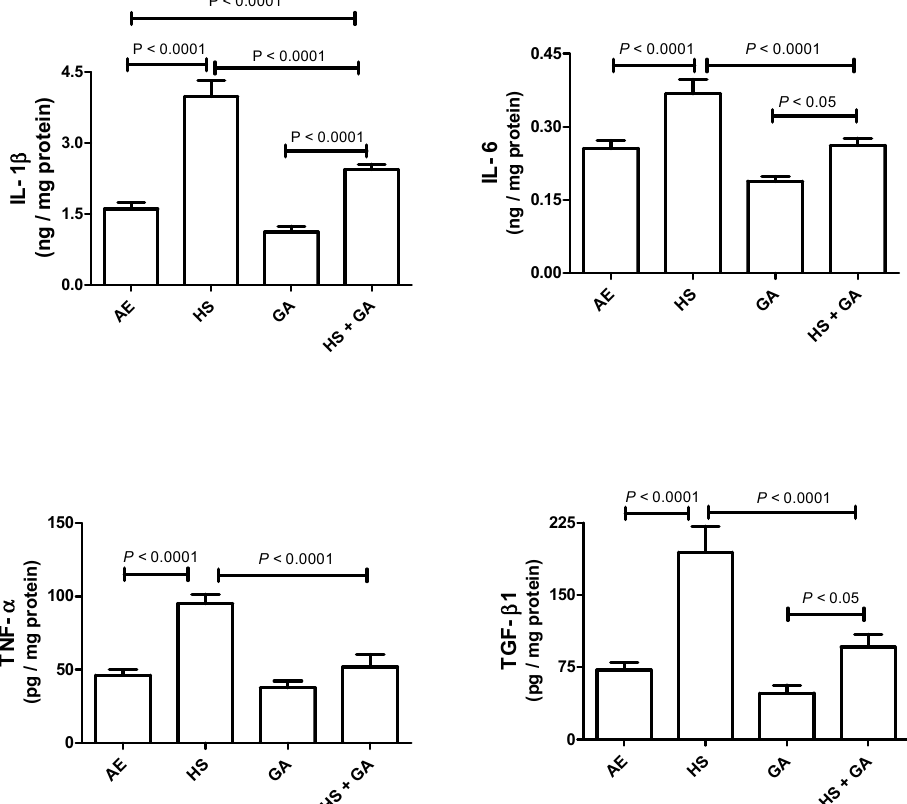
Figure 2. The testicular homogenate concentrations of interleukin 1-beta (IL-1 β ), interleukin-6 (IL-6), tumor necrosis factor (TNF- α ), and transforming growth factor-beta1 (TGF- β 1) in mice exposed to normal air (AE) and hookah smoke (HS, 30 min / day) or treated with gum acacia (GA, 15% w / v ) with or without exposure to HS. Each vertical column with bar represents the mean ± SEM ( n = 8). The p < 0.05 was considered significant.